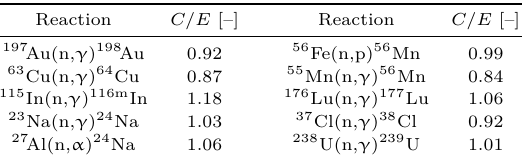
Table 3. C/E ratios of reactions used for the spec- trum